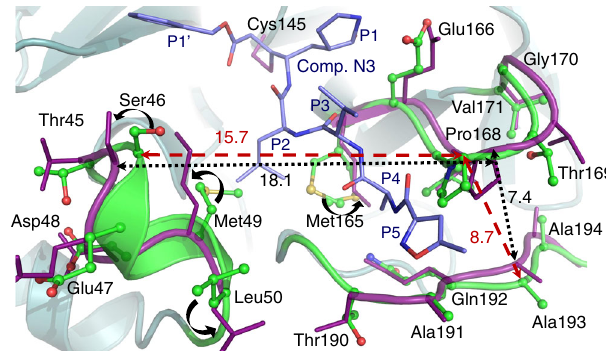
Fig. 4 Comparison of the active site geometries in the ligand-free and ligand-bound structures. Superposition of the room temperature ligand- free structure of 3CL M pro (green carbon atoms) with the structure of 3CL M pro in complex with inhibitor N3 (deep purple, PDB ID 6LU7) from SARS- CoV-2. Upon inhibitor binding, residues Met49, Leu50, and Met165 change their conformations (curved black arrows), whereas the small helix with residues 46 – 50 and the β -hairpin loop with residues 166 – 170 move apart, resulting in the loop with residues 190 – 194 which accommodates the inhibitor ’ s P5 substituent to shift closer to the β -hairpin loop. All distances are given in